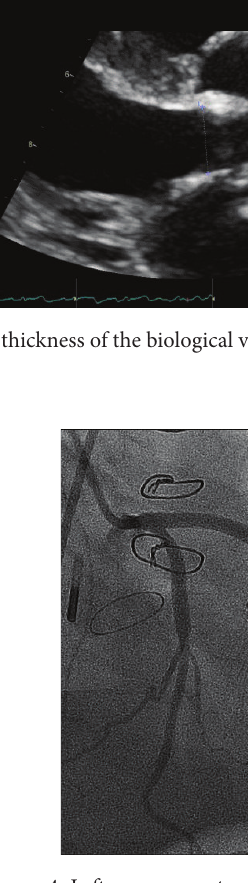
Figure 4: Left coronary artery in RAO caudal projection showing the final result after the PCI of the distal LMCA and proximal portions of the LAD and LCx arteries. RAO, right anterior oblique; PCI, percutaneous coronary intervention; LMCA, left main coro- nary artery; LAD, left anterior descending; LCx, left